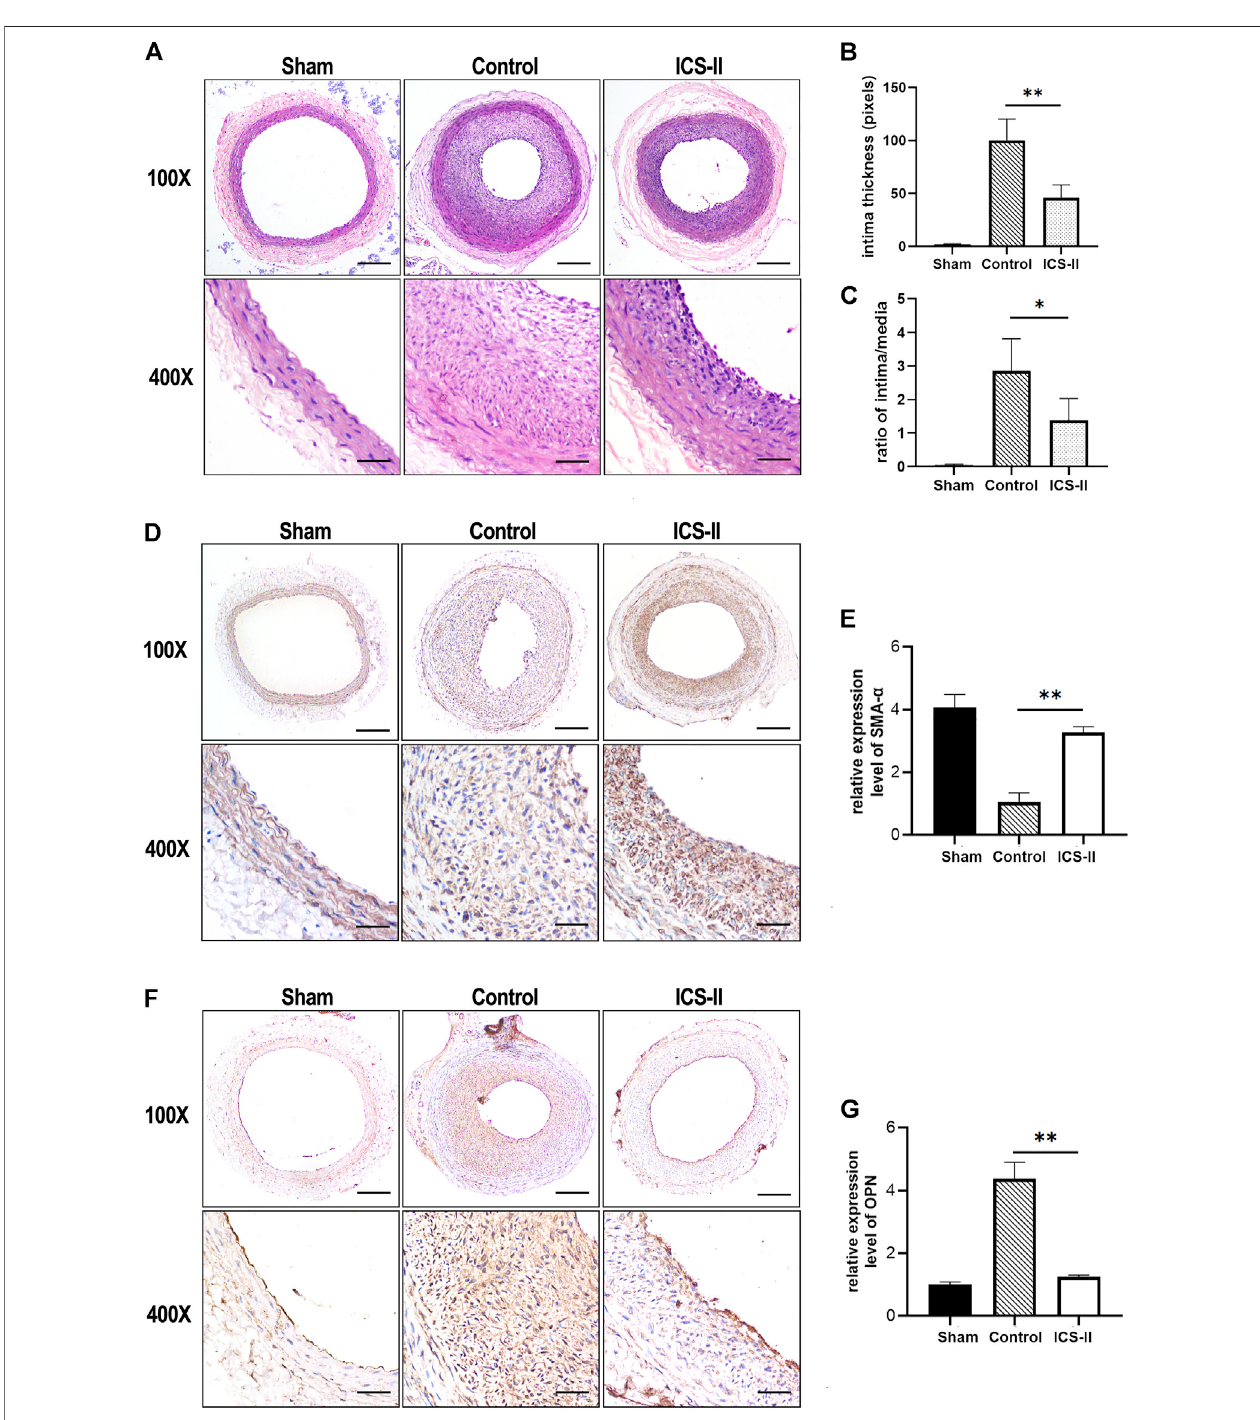
FIGURE 1 | ICS-II attenuated vascular remodeling and restored the VSMC contractile phenotype in vivo. (A) Representative H&E staining images of the injured left common carotid arteries from the sham group, control group, and ICS-II group, respectively. (B) Quanti fi cation of the intima thickness. (C) The lesion was calculated usingtheratioofintima/media. (D) RepresentativeIHCimagesofSMA- α intheshamgroup,controlgroup,andICS-IIgroup,respectively. (E) Quanti fi cationoftheSMA- α expression level in vivo. (F) Representative IHC images of OPN in the sham group, control group, and ICS-II group, respectively. (G) Quanti fi cation of the OPN expression level in vivo. X100, scale bar = 100 μ m; X400, scale bar = 20 μ m; Data are presented as mean ± S.E.M. N = 5 per group. * p < 0.05, ** p < 0.01, *** p < 0.001, **** p < 0.0001.